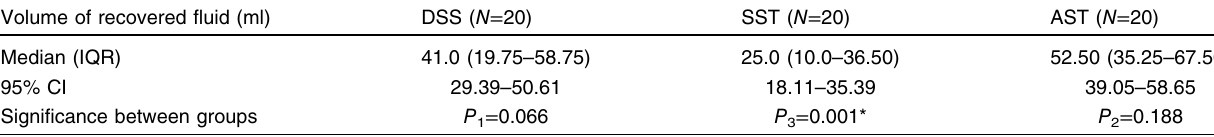
Significance between groups P 1 = 0.066 Abnormally quantitative data expressed in median (IQR) and was compared using Kruskal–Wallis test. AST, aspirator suction with trap group (III); CI, confidence interval; DSS, direct syringe suction group (I); IQR, interquartile range; LSD,